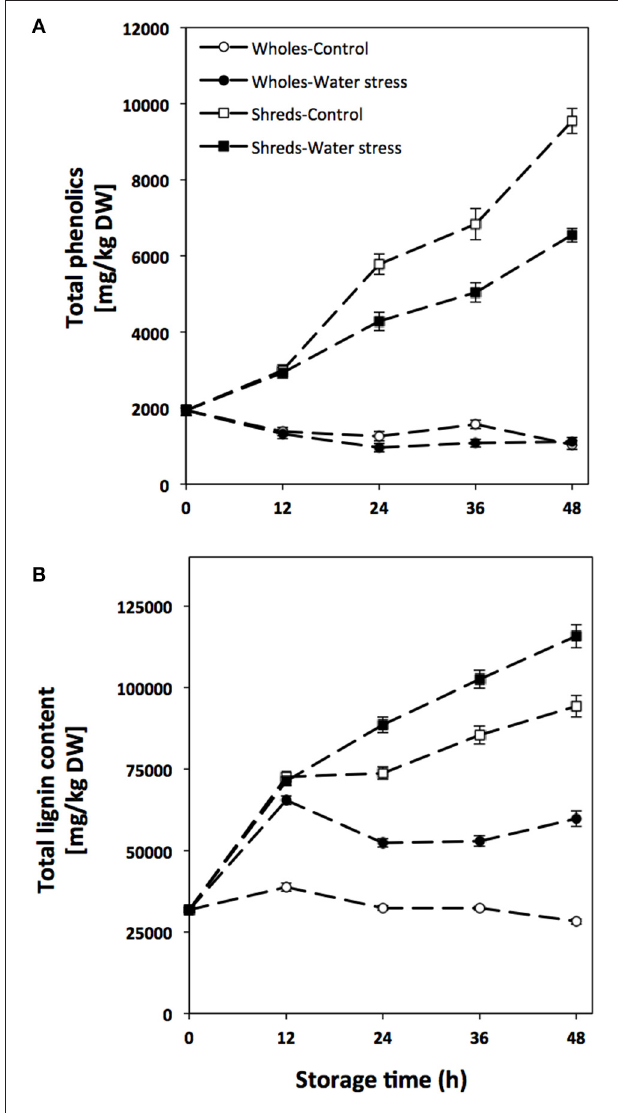
FIGURE 2 | Total phenolics (A) and total lignin content (B) of whole and shredded carrots stored for 48h under control and water stress conditions. Values represent the mean of 3 replicates with their standard error